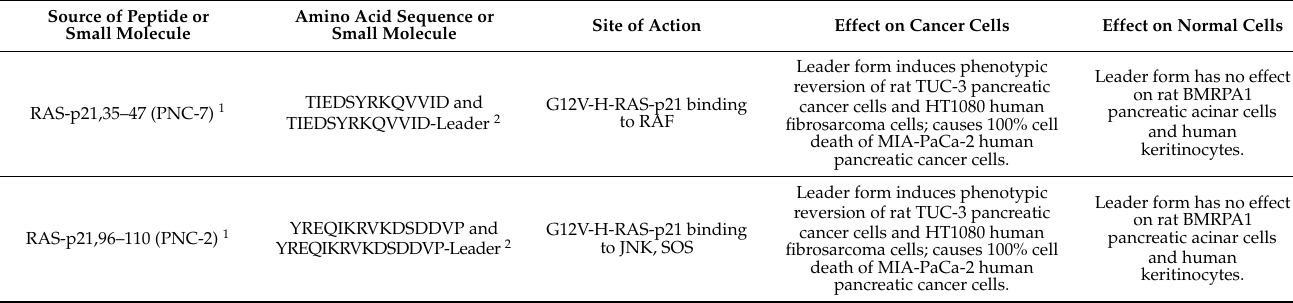
Table 1. Peptides and Small Molecules that Block Oncogenic